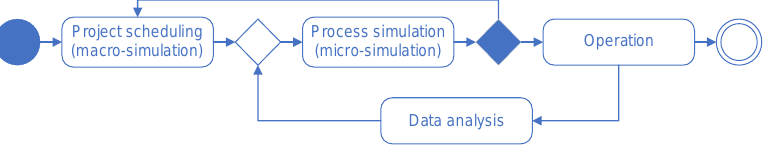
Figure 1. Production feedback control system of DTC (adapted from Fischer et al. [29].)